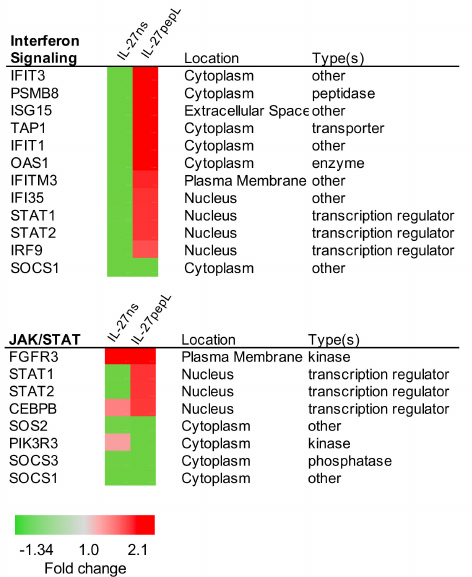
Figure 5. Top canonical pathways and regulators that di ff ered between IL-27pepL and controls.